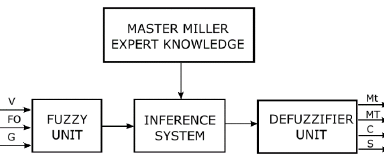
Figure 7. Fuzzy Rule-Based System. Viscosity, floating oil, and granularity (V, FO, and G respectively) are the inputs. Malaxing time, malaxing temperature, coadjuvant addition and speed of the shovels (Mt, MT, C and S respectively) represents the outputs.